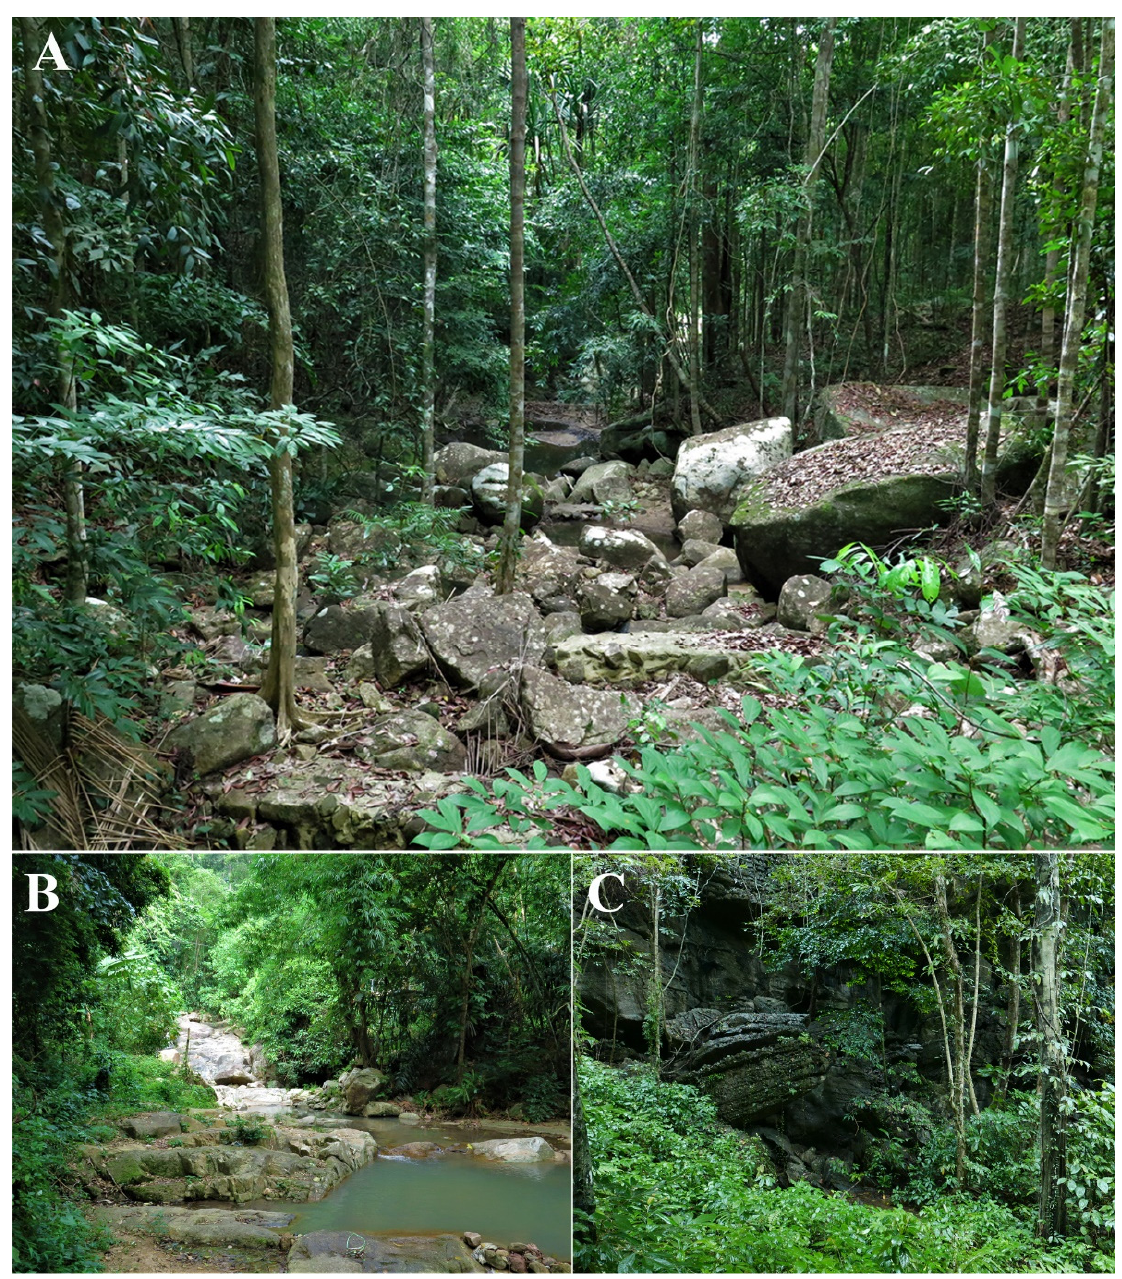
Figure 9. Sampling localities of Limnonectes pseudodoriae sp. nov . at ( A ) the type locality in Pheang Waterfall, Ko Pha-ngan Island, Surat Thani Province, ( B ) Song Reau Waterfall, Ko Samui Island, Surat Thani Province, and ( C ) Tham Khao Mai Kaew Cave, Ko Lanta Yai, Krabi Province.